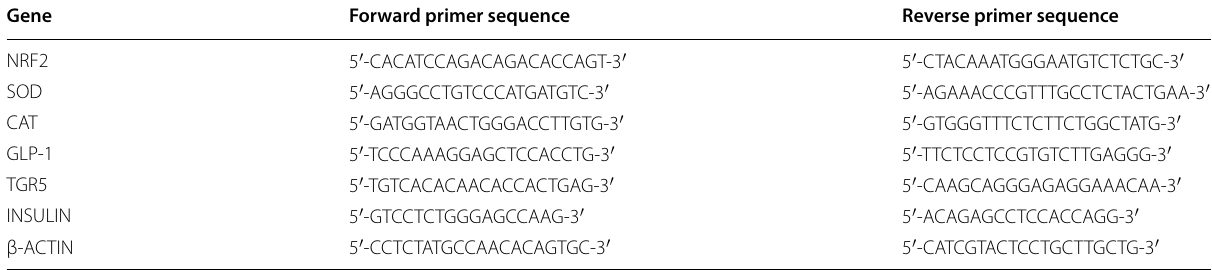
Table 1 Primer sequence Gene Forward primer